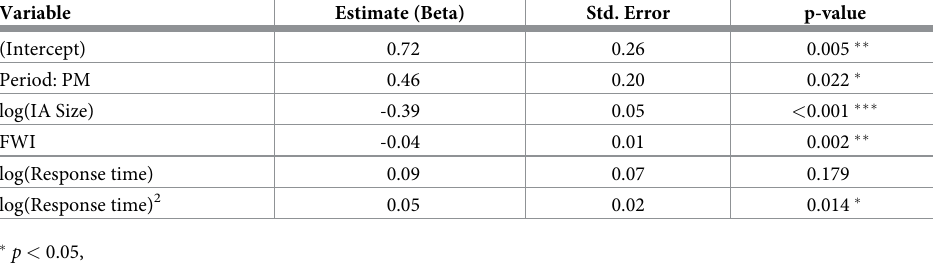
Table 4. Parameter estimates, standard errors (Std. Error) and p-values from the fitted logistic regression (GLM) model. Variable